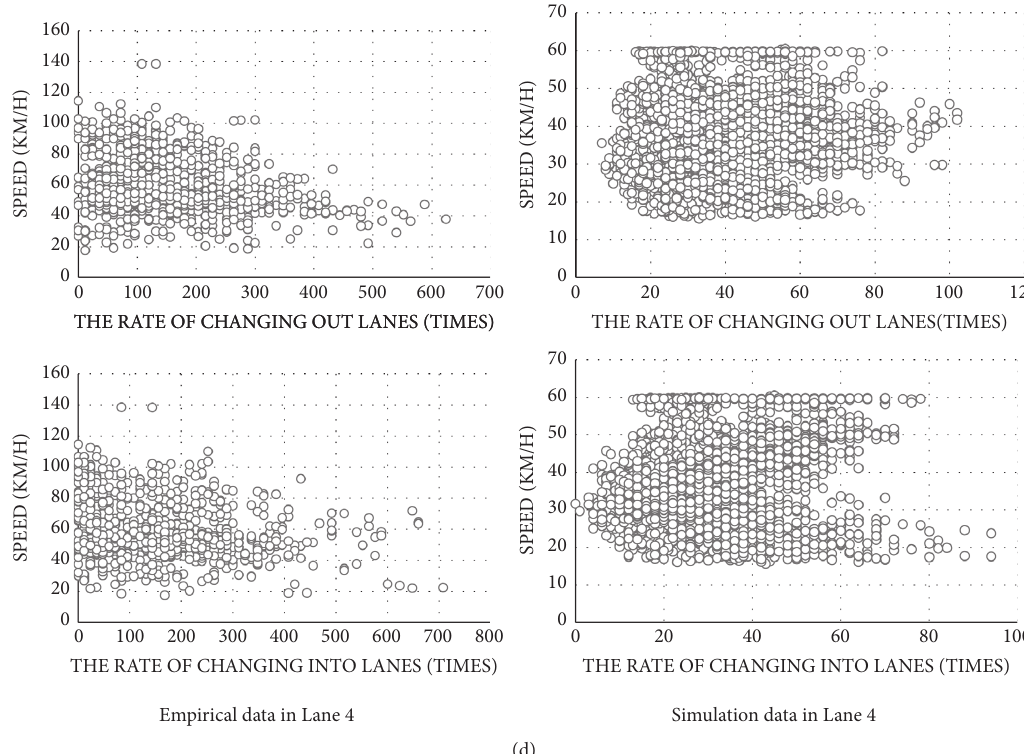
Figure 7: A scatter diagram of the relationship between the speed and the rate of changing out of lanes, and the relationship between the speed and rate of changing into lanes in each lane in the empirical data and simulation data. (a) The scatter plot of Lane 1. (b) The scatter plot of Lane 2. (c) The scatter plot of Lane 3. (d) The scatter plot of Lane